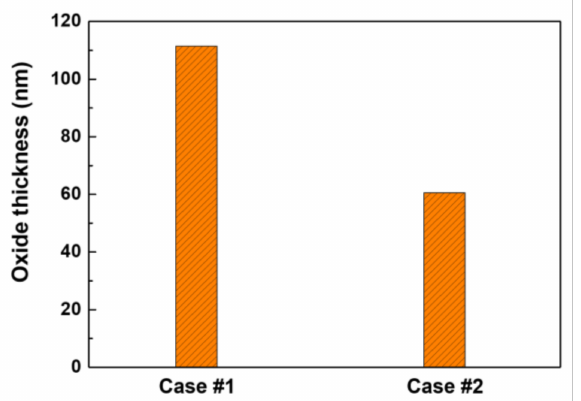
Figure 11. Oxide thicknesses determined using the oxide weight and